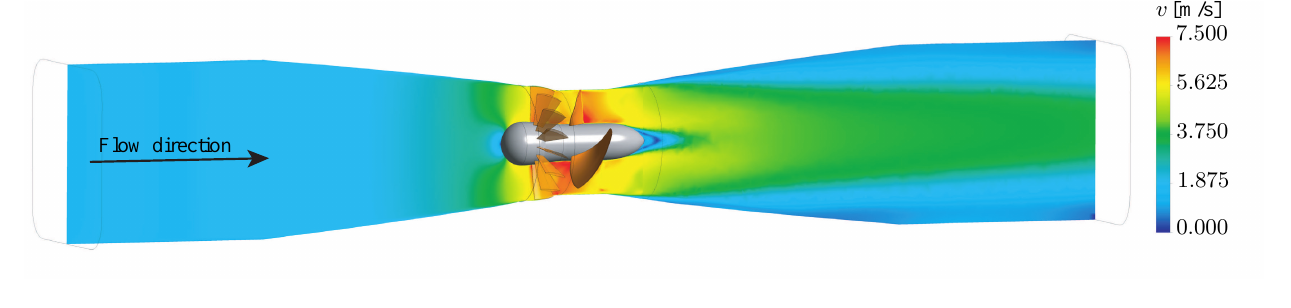
Fig. 11. Velocity distribution in turbine mode